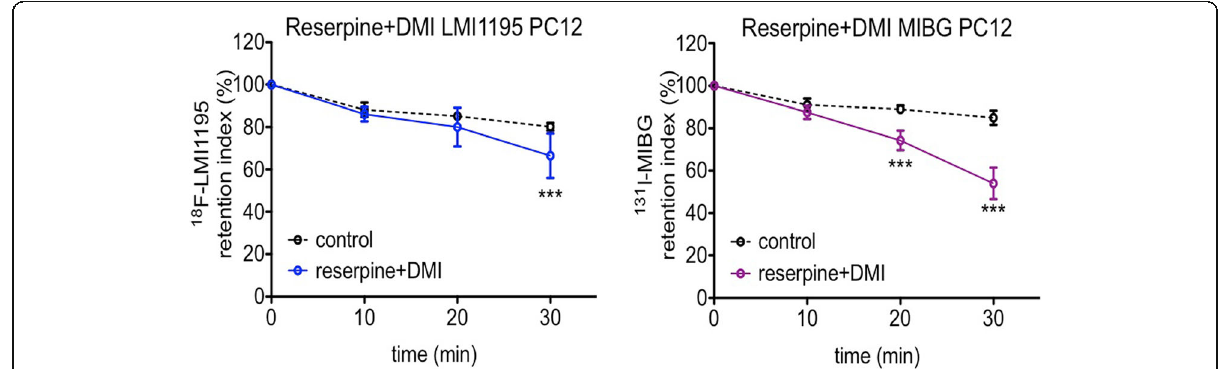
Fig. 4 Co-exposing preloaded PC12 cells to reserpine and desipramine. The co-treatment also induced tracer release in the same mode as using reserpine alone. The release indices of either 18 F-LMI1195 (left, n = 6 at each time point of both groups) or 131 I-MIBG (right, n = 6 at each time point of both groups) reached significant differences compared to controls after 30 min. *** p < 0.001 vs. control group at the same time point; all data points presented as mean ±